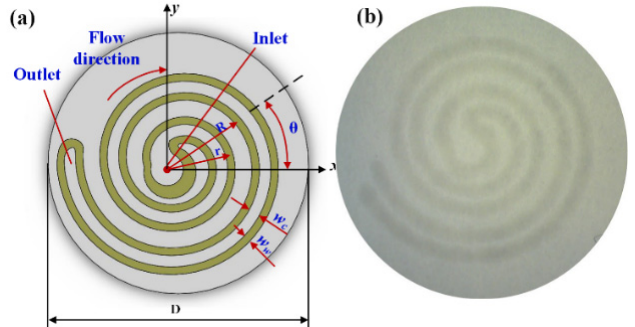
Figure 2. Sweat channel with double spiral structure: ( a ) structure sketch and ( b ) photomicrograph of the wax channel impressed on filter paper using a mold.